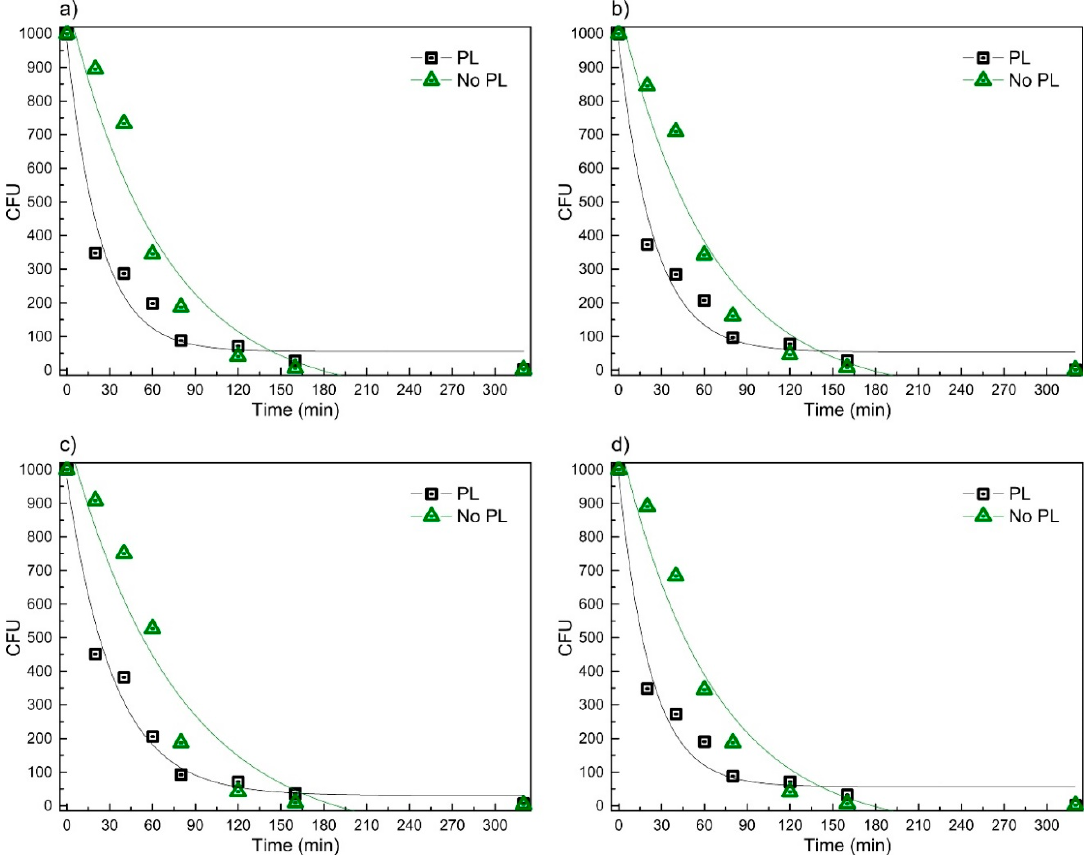
Figure 7. Time dependencies of bacteria colony forming units (CFU) versus time using the spread-plate technique for the bandage prototype (PL) and the reference sample (No PL) measured with four types of S. aureus bacteria strains: ( a ) LTSaDA01; ( b ) LTSaM01; ( c ) LTSa635 and ( d ) LTSa603. Table 2. Coefficients of exponential dependencies used in the approximations of CFU versus time for four types of S. aureus bacteria